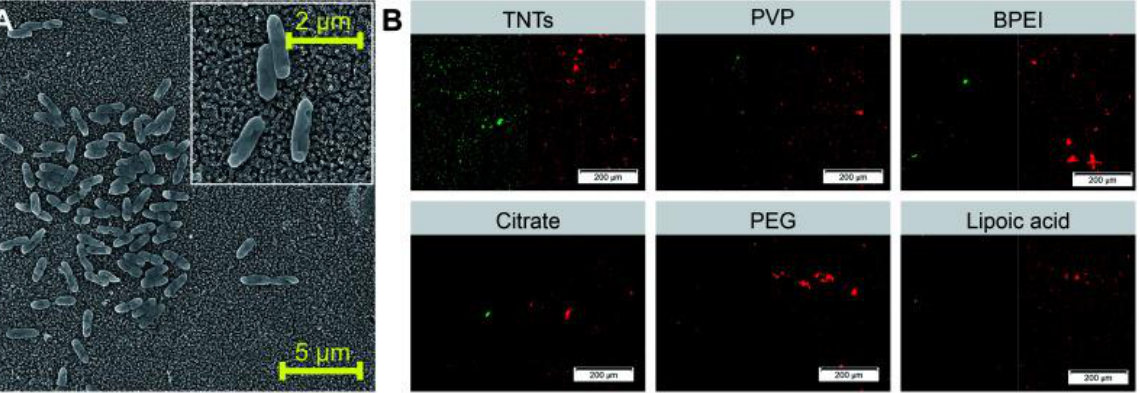
Figure 11. ( A ) SEM images of P. aeruginosa adhered on control TNT sample and bacteria shown in detail in the insert of ( A ). ( B ) Live/dead fluorescence images of P. aeruginosa adhered on differently functionalized Ag – NPs decorated on TNTs (red = dead cells; green = live cells). Abbreviations: polyvinylpyrrolidone, PVP; branched polyethyleneimine, BPEI; polyethylene glycol, PEG. Reproduced from [145].